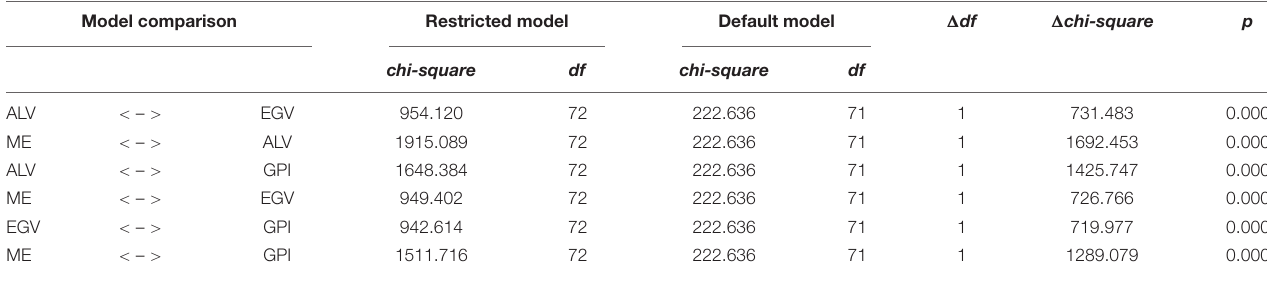
TABLE 3 | Discriminant validity test ( N =